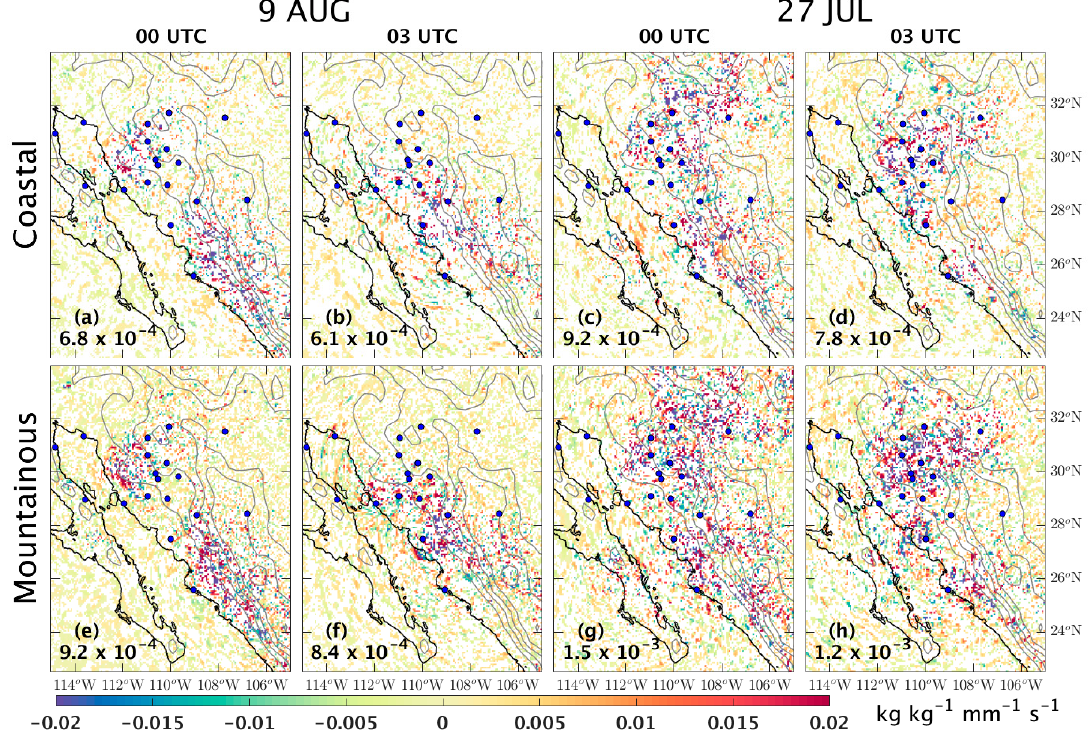
Figure 12. This figure displays the mean hourly sensitivity of WRF-GFS QCONV across the domain, relative to the WRF-GFS-equivalent initial PWV in the coastal and mountainous sites, at 0000 UTC and 0300 UTC for both weakly ( a , b , e , f ) and strongly ( c , d , g , h ) forced days. Smoothing is applied by scaling up the grid spacing from 2.5 km to 1/16°. Only statistically significant correlations (p < 0.05) are displayed. The mean of absolute value across the domain is displayed on the lower left on each panel. The mountainous sites exhibit higher values than the coastal sites on both weakly and strongly forced